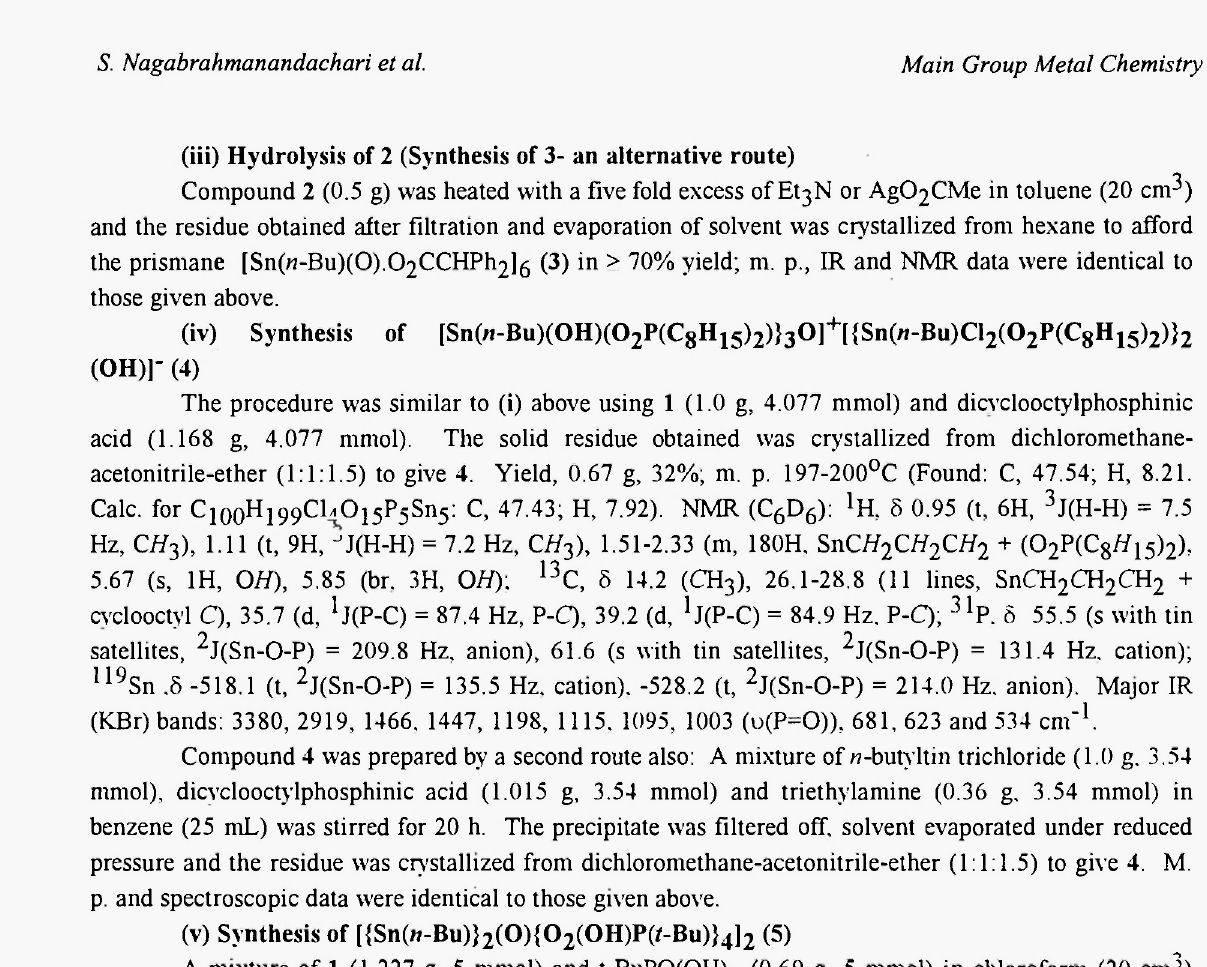
Compound 6 crystallized after reducing the